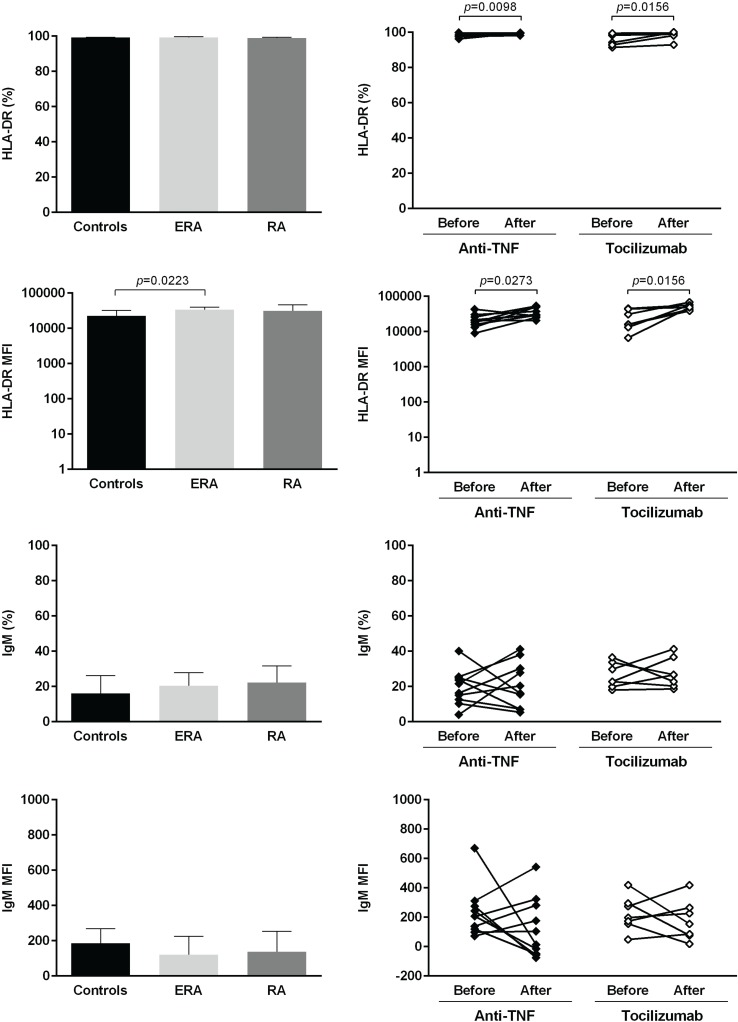
The frequency of HLA-DR+ B cells and HLA-DR MFI increase after treatment with TNF-inhibitors and tocilizumab in rheumatoid arthritis.The expression of cell markers related to antigen presentation (HLA-DR) and B-cell receptor (IgM) was analyzed on B-cells (frequency and median fluorescence intensity, MFI) to characterize B-cell phenotype in circulation in early RA (ERA) and established RA patients under methotrexate treatment. The effect of TNF-inhibitors and tocilizumab treatment on B-cell markers expression was also assessed in established RA patients at baseline and after an average of 8 months of treatment. Bars represent median values with interquartile range. Differences were considered statistically significant for p<0.05. Non-parametric Mann-Whitney test was used for comparisons between 2 independent groups. For paired samples (before and after treatment), the Wilcoxon signed-rank test was used.